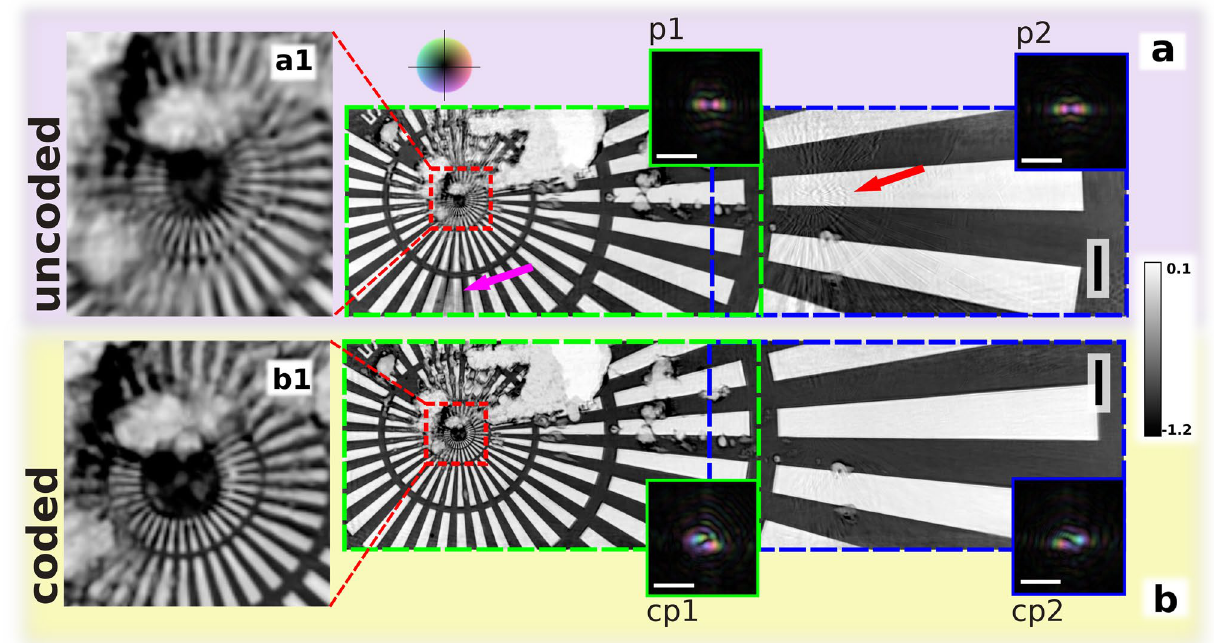
Figure 2. Reconstructed images of a Siemens star test sample and corresponding probes. Red and purple arrows show reconstruction defects. Blue/green dashed rectangles show which probe scanned which region of the sample: ( a ) uncoded probe case with the probes shown in (p1) and (p2), ( a1 ) is the magnified center of the test pattern; ( b ) coded probe case, with the probes shown in (cp1) and (cp2), ( b1 ) is the magnified center of the test pattern. The vertical scale bars represent 3 μm, the horizontal scale bars represent 4 μm. The gray scale indicates the sample phase shift in radians. Phases of the probes are